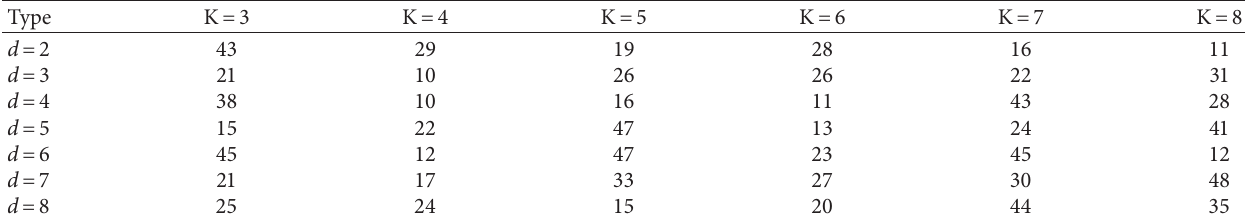
Table 2: Behavioral data used in the student psychological state perception